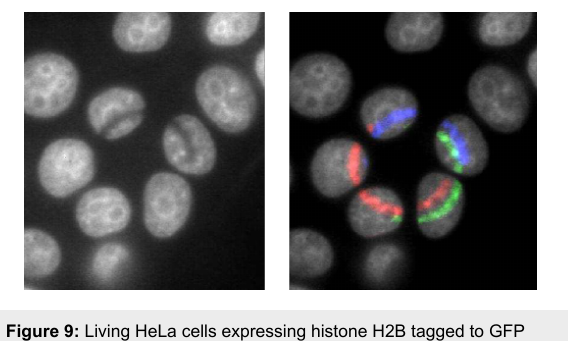
Figure 9: Living HeLa cells expressing histone H2B tagged to GFP were photobleached. Bleaching within a region of three sectors of a circle depletes fluorescence from the bleached region. Colors of the three regions were adjusted with ImageJ and the different channels were merged. From [19] – Copyright: GSI Helmholtzzentrum für Schwerionenforschung